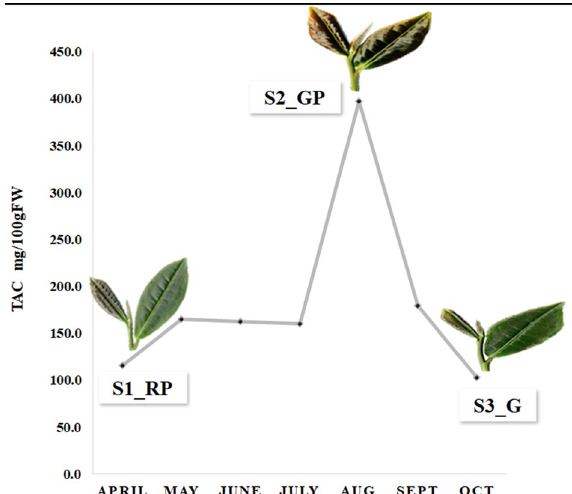
Figure 1. Leaf color transition and variation in total anthocyanin content.